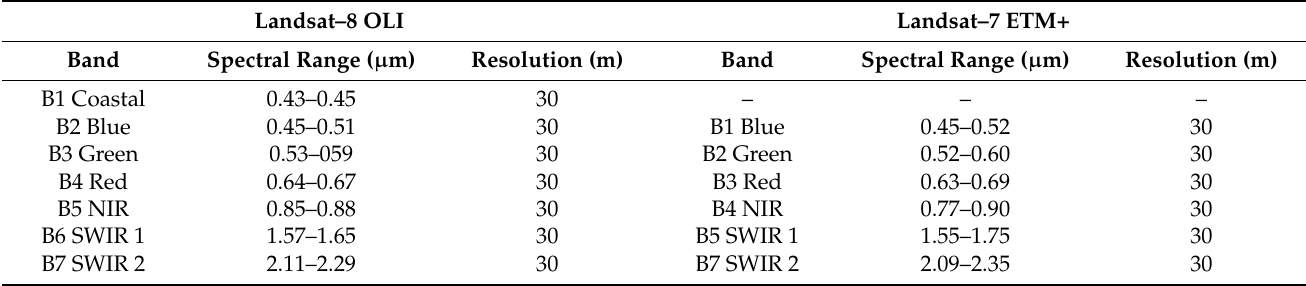
Table 2. Detailed parameter comparison of the OLI and ETM+